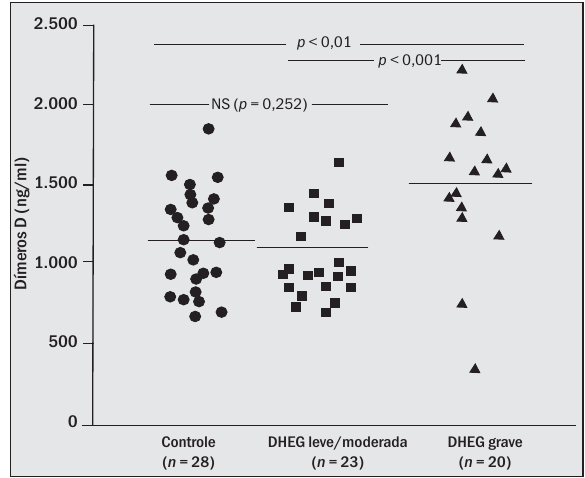
Figura 2 – Níveis plasmáticos de dímeros D/D-Di (ng/ml) determinados por Elisa. A linha horizontal mostra a média dos valores